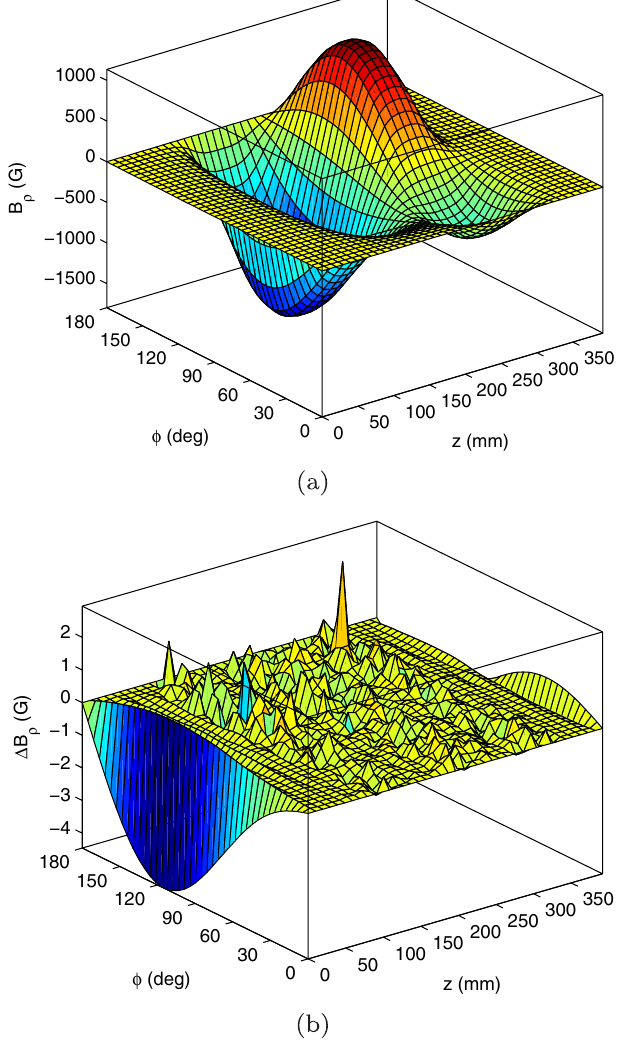
FIG. 2. (a) Radial component of the magnetic field and (b) residual of the fit on a reference cylinder of radius 15 mm within one EMMA